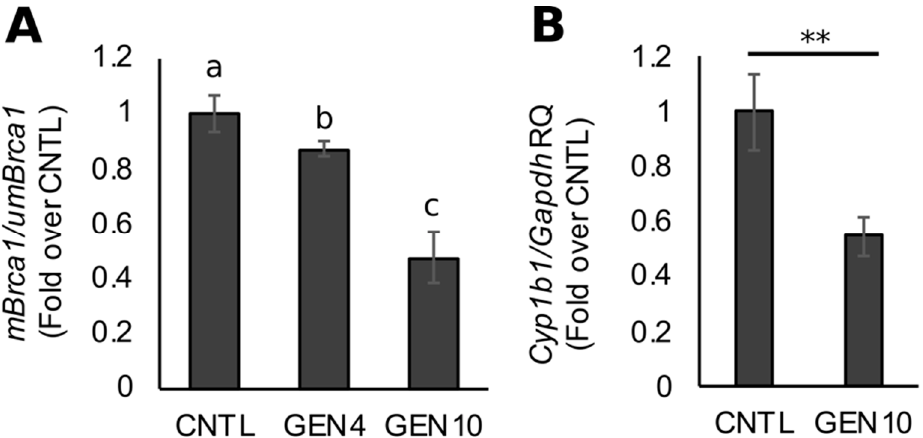
Figure 1. Lifetime exposure to genistein (GEN) decreases basal Brca1 cytosine-guanine dinucleotide (CpG) methylation and aryl hydrocarbon receptor (AHR) activity in mouse o ff spring mammary tissue. Mice were exposed to diets containing 0, 4, or 10 ppm GEN starting at conception and through nursing, weaning, and adulthood. ( A ) Brca1 CpG methylation in a mammary gland of post-natal day 50 (PND50) female o ff spring. Bars represent the mean ratios of methylated Brca1 to unmethylated Brca1 amplicons ± SEM from ≥ 7 individual animals. ( B ) Cyp1b1 mRNA expression in PND50 mammary glands. Bars represent mean RQ ± SEM from ≥ 7 individual animals. Means with di ff erent letters (a > b > c) or asterisks (**, p < 0.01) indicate statistical significance ( p < 0.05).